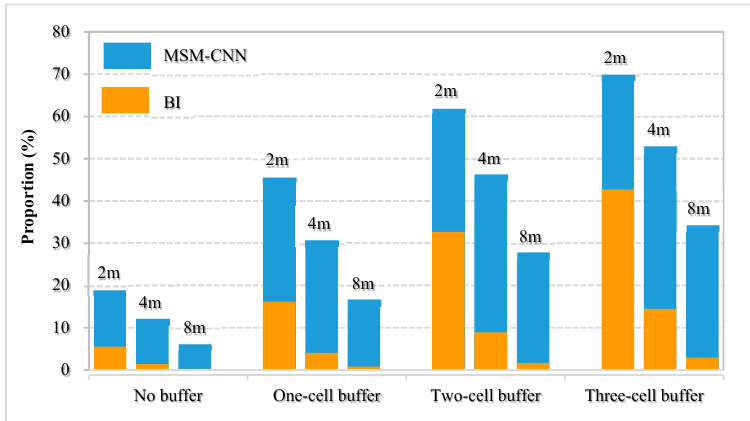
Figure 12. Morphological accuracy statistics of the building boundary reconstructions. The label of 2, 4, or 8 m on the top of each column denotes that the DEMs are reconstructed from the 2, 4, or 8 m low-resolution DEMs.